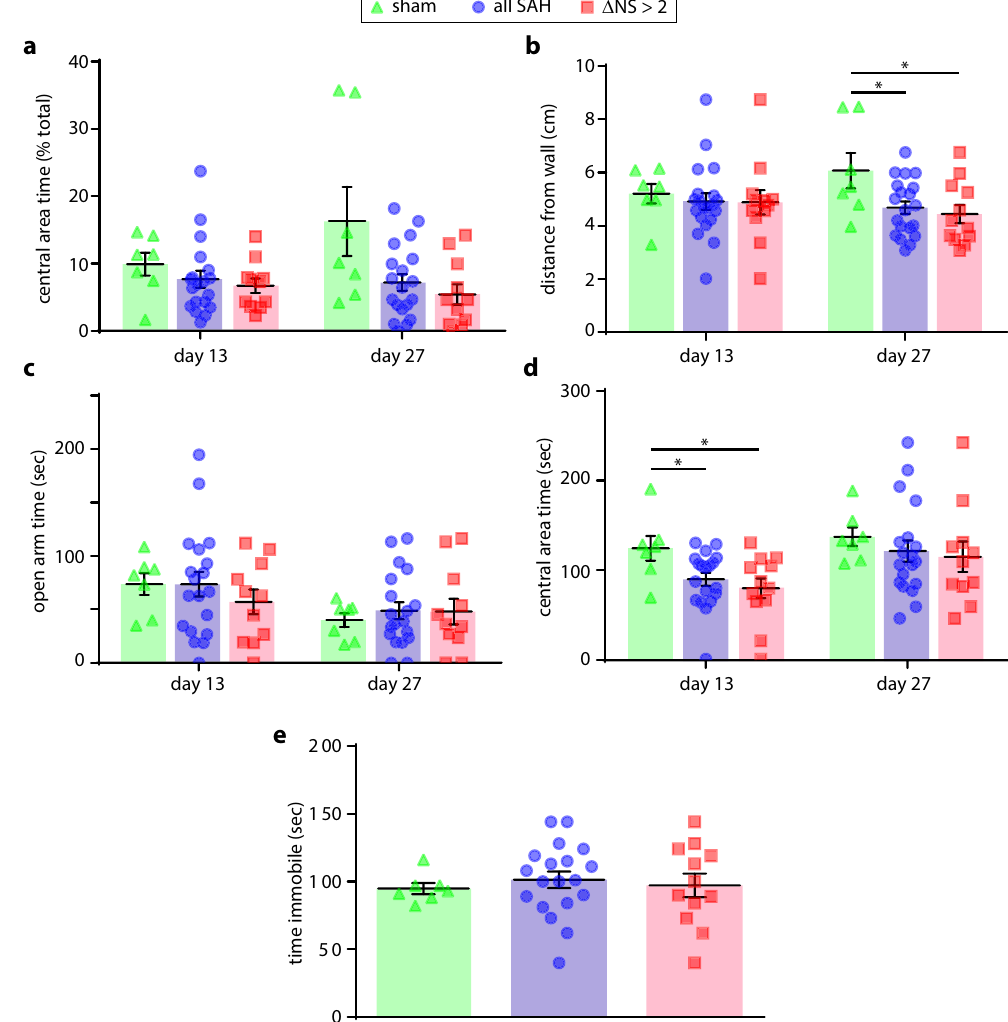
Figure 4. Anxiety and mood-related behaviors. Thigmotaxic behavior was quantified in the open field test by evaluating the percent time spent in a central region ( a ) and by calculating the average distance from the nearest wall at 13 and 27 days post-injury ( b ). Time spent in the open area ( b ) and central area ( c ) of the elevated plus maze was quantified. Time immobile during the tail suspension test ( d ). Mann-Whitney U test with Holm- Bonferroni correction for multiple comparisons ( a – c ). t-test with Holm-Bonferroni correction for multiple comparisons ( d , e